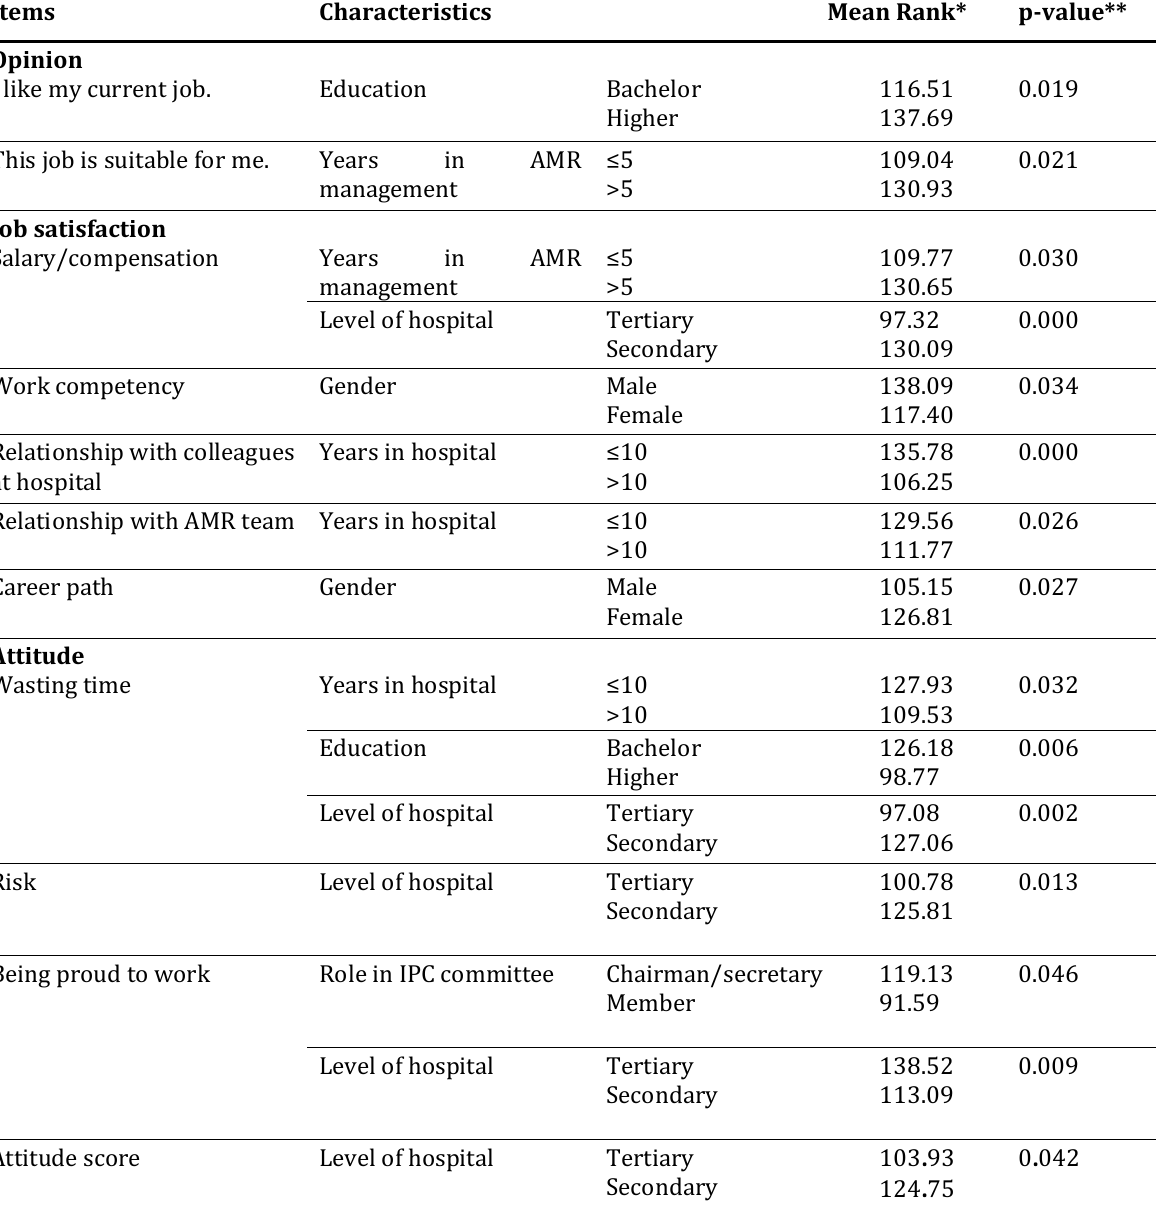
Table 5: The significant associations between pharmacists’ characteristics and their opinions,